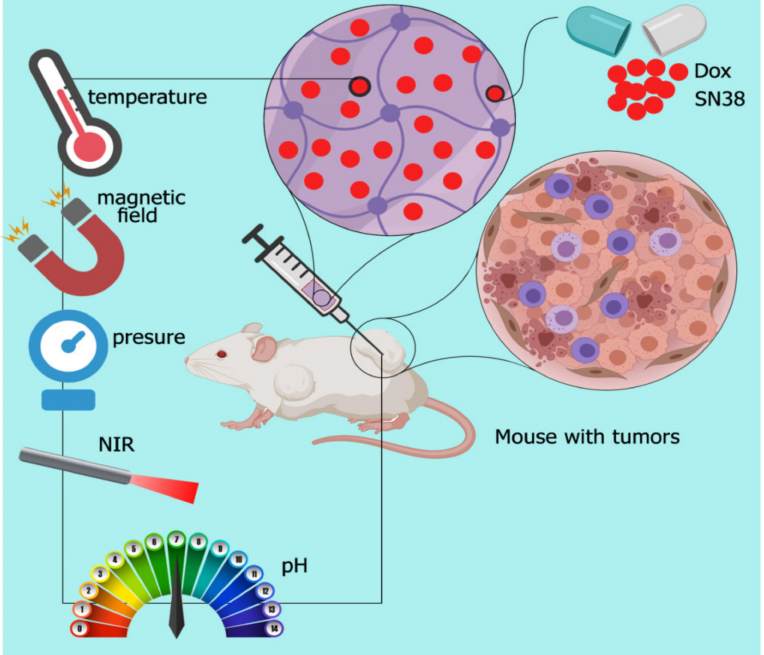
Figure 3. Schematic of external-responsive hydrogels. Combination therapy through sustained released anti-cancer drug from smart hydrogel, which changes formation in response to the external